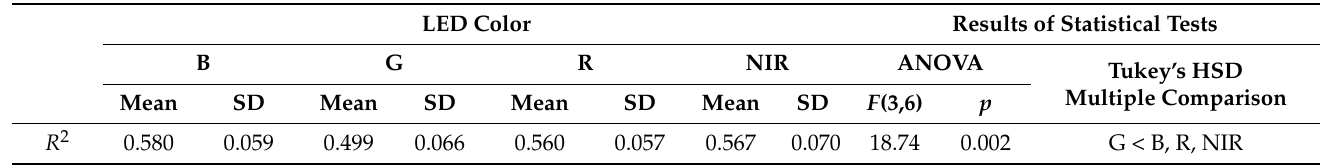
Table 6. Coefficient of determination at each wavelength of PPG and results of statistical tests. LED Color Results of Statistical